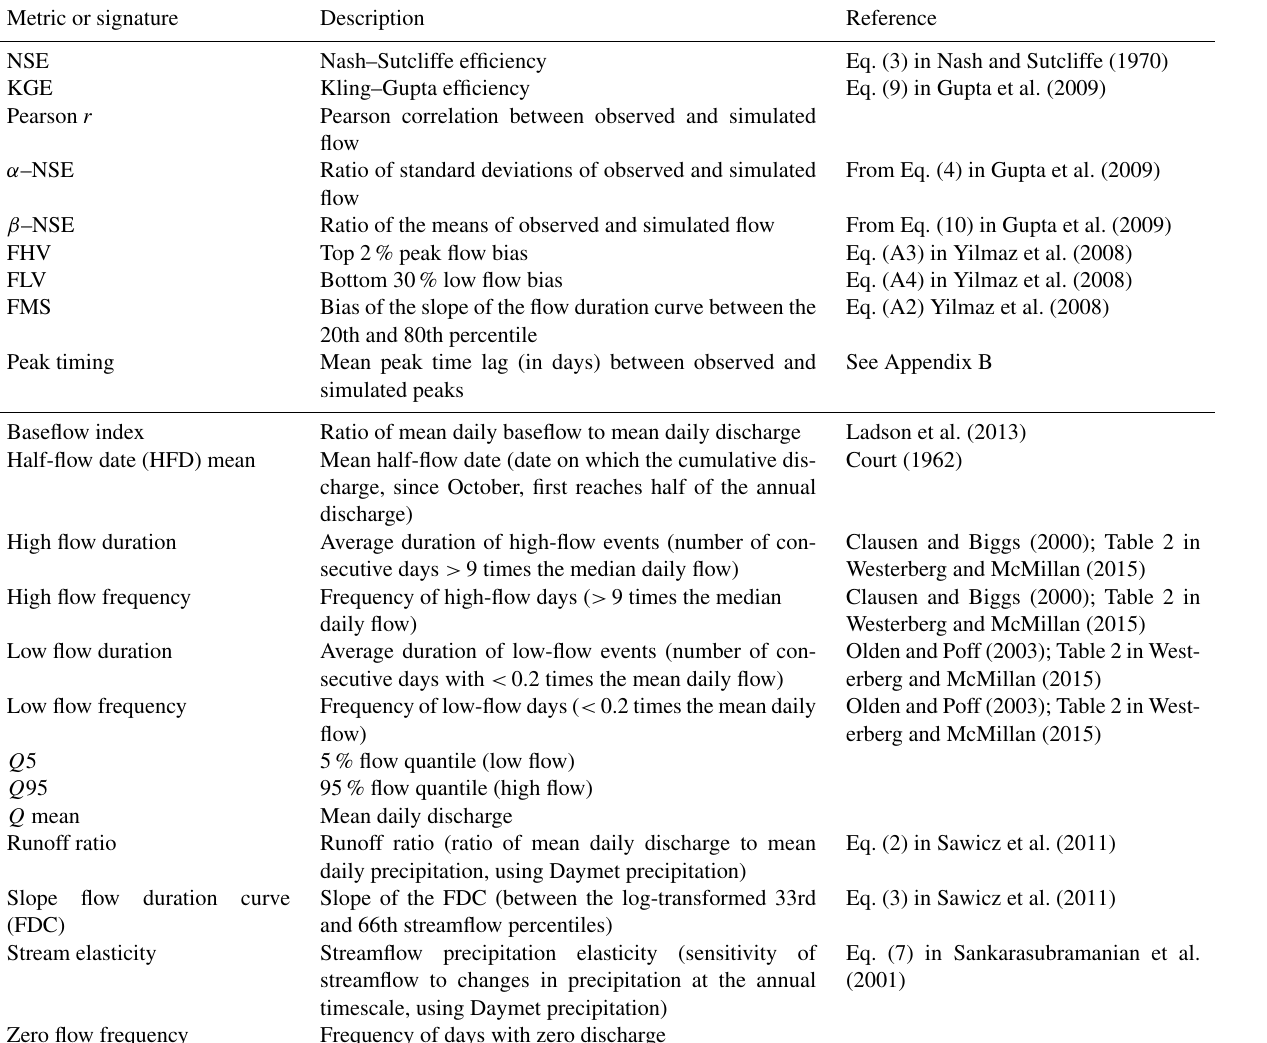
Table 1. Description of the performance metrics (top part) and signatures (bottom part) considered in this study. For each signature, we derived a metric by computing the Pearson correlation between the signature of the observed flow and the signature of the simulated flow over all basins. Description of the signatures taken from Addor et al.